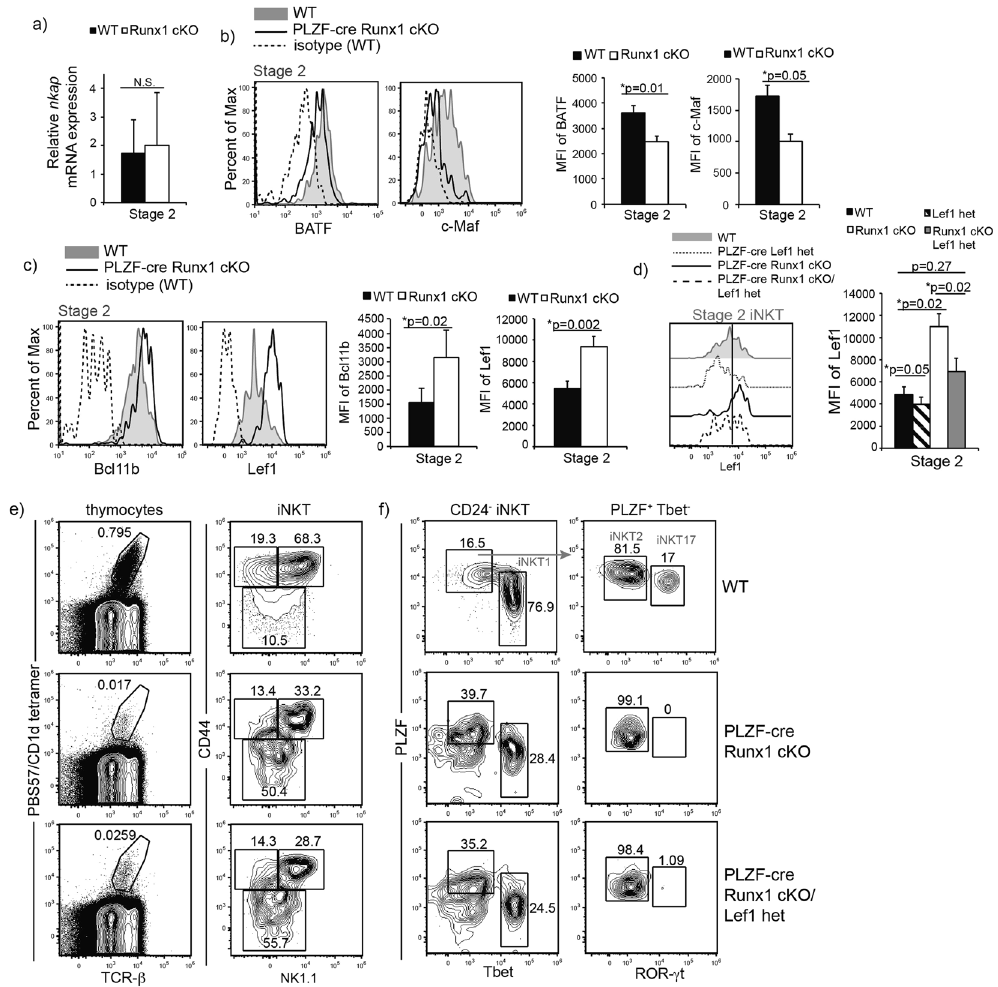
Figure 6. Runx1-deficient iNKT cells exhibit a dysregulated transcriptional program required for iNKT17 cell differentiation. (a ) Relative mRNA expression of nkap in sorted Stage 2 iNKT cells of WT (black bar) and PLZF-cre Runx1 cKO mice (white bar). Data is calculated from 3 WT and 3 PLZF-cre Runx1 cKO mice. ( b ) Intracellular expression of BATF and c-Maf in Stage 2 iNKT cells of WT (grey filled), PLZF-cre Runx1 cKO mice (black line) and isotype control (dashed line). Quantification of MFI for BATF and c-Maf in Stage 2 iNKT cells of WT (black bar) and PLZF-cre Runx1 cKO mice (white bar). Data is representative (histogram overlays) and calculated from at least 11 mice/genotype from 5 independent experiments. ( c ) Intracellular expression of Bcl11b and Lef1 in Stage 2 iNKT cells in WT (grey filled) and PLZF-cre Runx1 cKO mice (black line). Quantification of MFI for Bcl11b and Lef1 in Stage 2 iNKT cells of WT (black bar) and PLZF-cre Runx1 cKO mice (white bar). Data is representative (histogram overlays) and calculated from at least 6 mice/genotype from 4 independent experiments for Bcl11b and 11 mice/genotype from 6 independent experiments for Lef1. ( d ) Lef1 expression in Stage 2 iNKT cells from WT (grey filled), PLZF-cre Lef1 het (dotted line), PLZF-cre Runx1 cKO (black line) and PLZF-cre Runx1 cKO/Lef1 het (dashed line) mice. Quantification of MFI of Lef1 in Stage 2 iNKT cells from WT (black bar), PLZF-cre Runx1 cKO (white bar) and PLZF-cre Runx1 cKO/Lef1 het (grey bar) mice and PLZF-cre Lef1 het (striped bar) mice. Data is representative (histogram overlay) and calculated from 4 mice/genotype from 4 independent experiments. ( e ) Development of iNKT cells in WT, PLZF-cre Runx1 cKO and PLZF-cre Runx1 cKO/Lef1 het mice. Gating was performed as described in Fig. 1. Data is representative of 4 mice/genotype from 4 independent experiments. ( f ) Representative frequency of iNKT subsets: iNKT1, iNKT2 and iNKT17 in WT, PLZF-cre Runx1 cKO and PLZF-cre Runx1 cKO/Lef1 het mice. Subsets gating were performed as described in Fig. 5. Data is representative of 4 mice/genotype from 4 independent experiments. All statistical analysis was done using Student’s t-test . Means ±